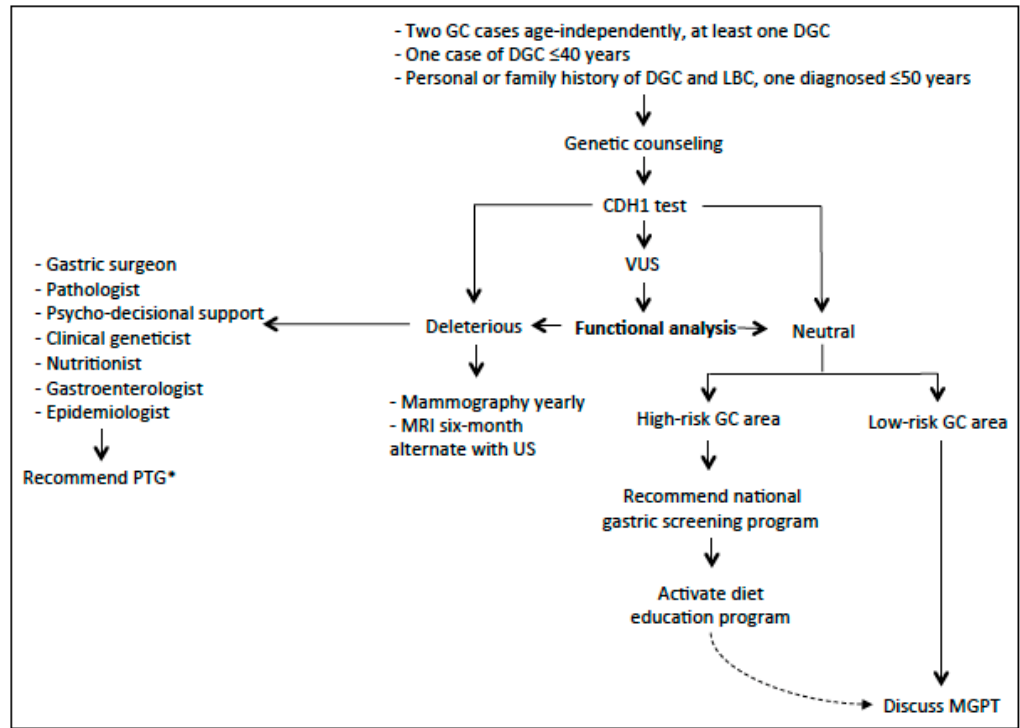
Figure 1. The flow-chart describes the clinical management of hereditary diffuse gastric cancer syndrome [* If refuse PTG (prophylactic total gastrectomy) consider gastric endoscopic surveillance with Cambridge protocol].